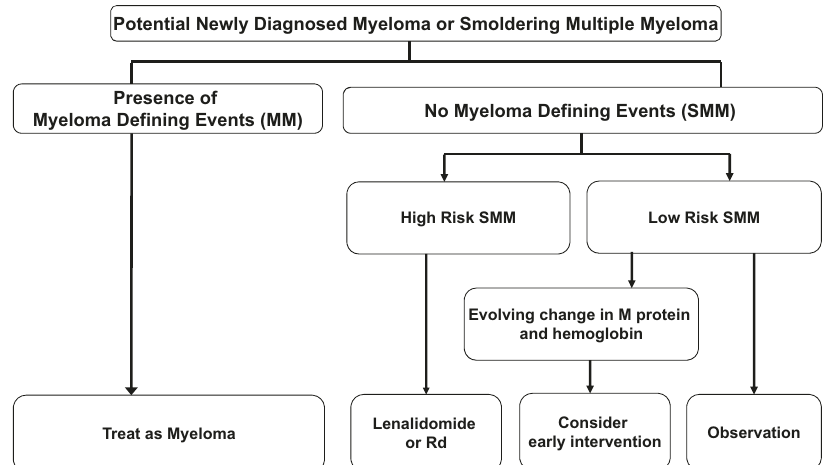
Fig. 1 Approach to the management of smoldering multiple myeloma. Footnote for Fig. 1: SMM, smoldering multiple myeloma; MM, multiple myeloma; Rd, lenalidomide plus dexamethasone. Myeloma De fi ning Events: End organ damage felt to be related to myeloma (hypercalcemia, light chain cast nephropathy, anemia, osteolytic bone lesions), serum free light chain ratio ≥ 100 with involved serum free light chain level ≥ 100 mg/dL and urine monoclonal protein ≥ 200 mg per 24 h on urine protein electrophoresis, ≥ 60% clonal bone marrow plasma cells, >1 focal lesion on magnetic resonance imaging. High risk Smoldering Multiple Myeloma: Any 2 of the following: bone marrow plasma cells >20%, serum monoclonal protein >2 gm/dL, serum free light chain ratio >20. Or high risk score based on the International Myeloma Working Group Scoring System for Smoldering Multiple Myeloma. Evolving change: Increase in monoclonal protein of 0.5 gm/dl or more along with a concomitant decrease in hemoglobin of 0.5 g/dl or more over a 12-month